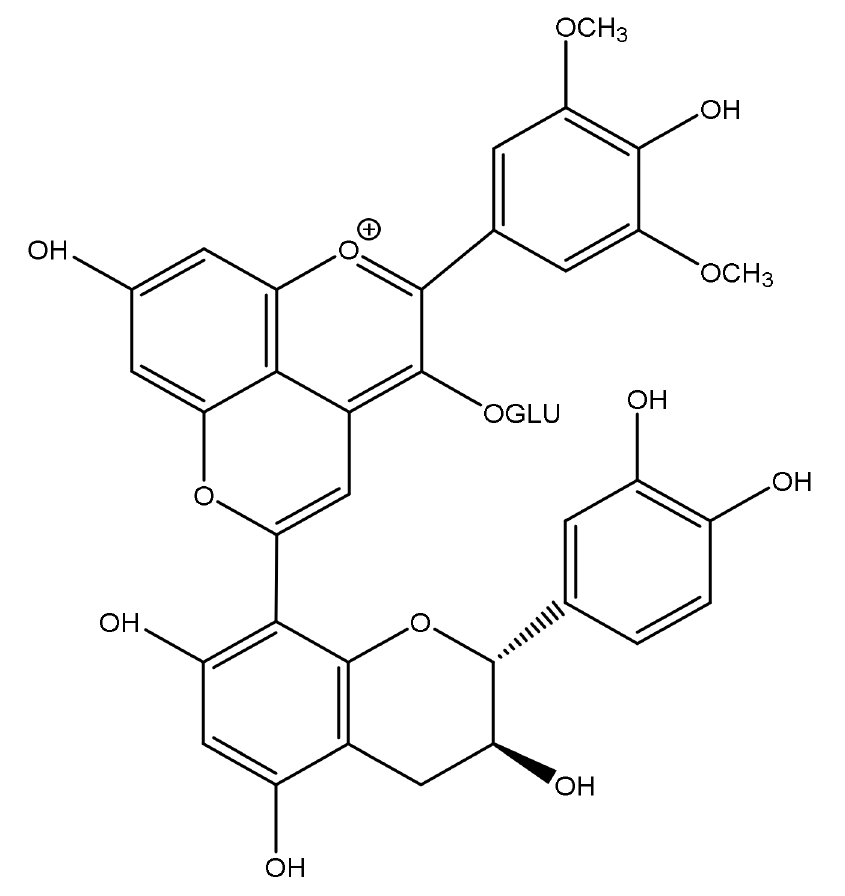
Figure 4. Structure of pyranomalvidin-3-O